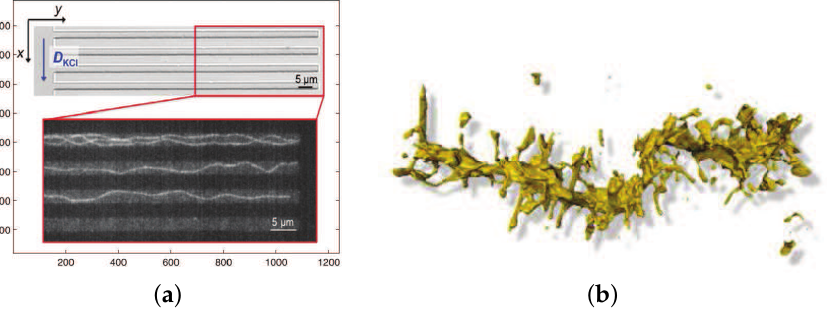
Figure 1. ( a ) Optical micrograph of a segment of the microfluidics comb-like structures (on top). On the bottom: microfluidic micrographs of fluorescently labeled, polymerized actin filaments in a comb-like structure [4]. ( b ) One of the examples of a physical environment suitable for the comb model. Electron tomogram of a spiny dendrite. Image taken from Internet (http://www.cacr.caltech. edu/projects/ldviz/results/levelsets/, accessed on 1 July 2013).